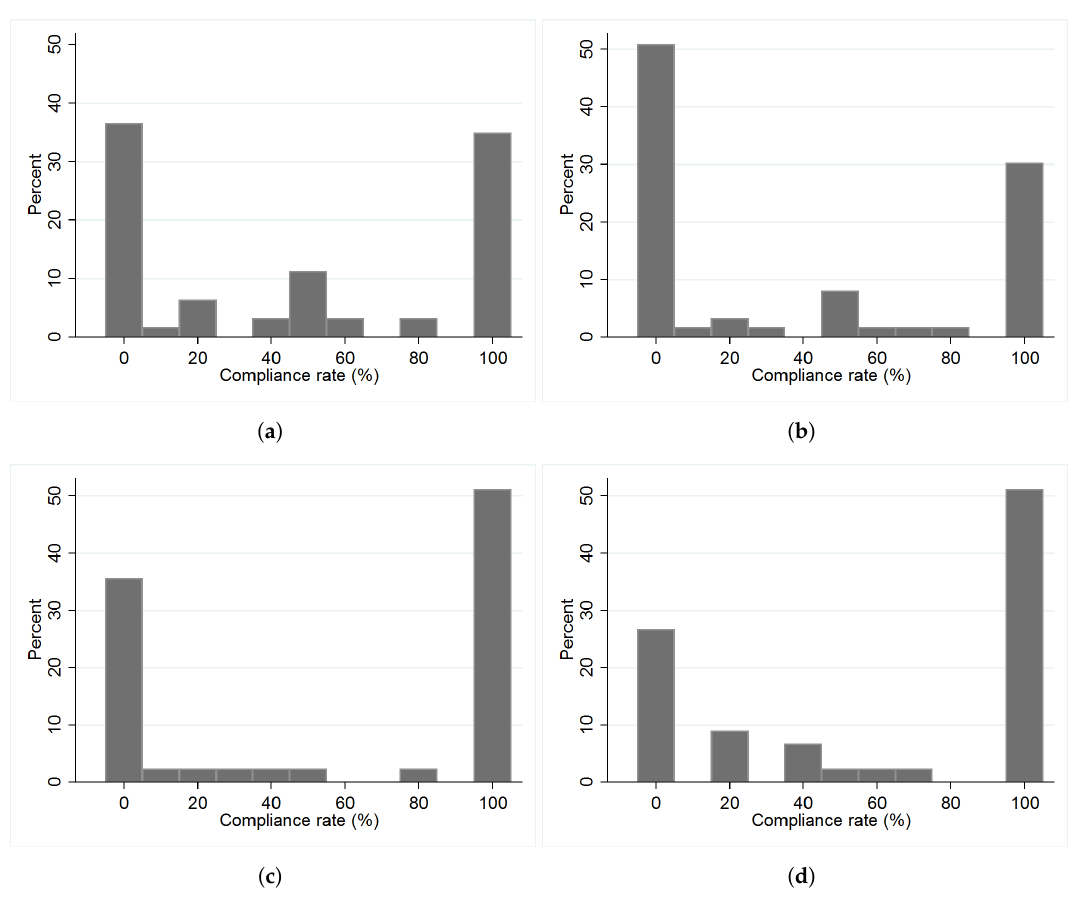
Figure 2. Distribution of low-income taxpayers’ compliance choices by treatment. Only the 216 observations of low-income taxpayers in groups of four are displayed. PBA = Performance-based allocation, RA = Random allocation. ( a ) PBA, without information (N = 63); ( b ) PBA, with information (N = 63); ( c ) RA, without information (N = 45); ( d ) RA, with information (N =